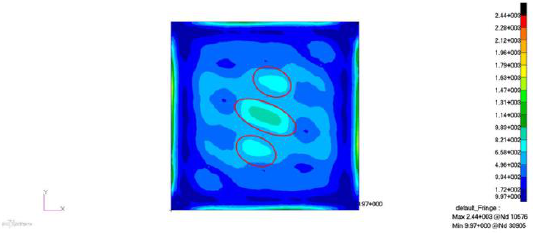
Figure 6. The weighted summation strain energy of the first 20 modes of the composite plate.